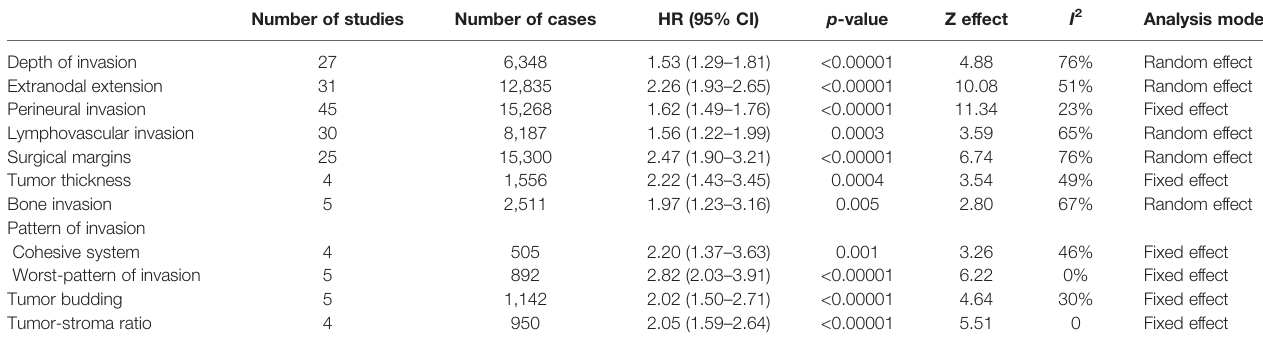
TABLE 3 | Effect of the selected histological features in the disease-free survival (DFS) of patients with oral squamous cell carcinoma. Number of studies Number of cases